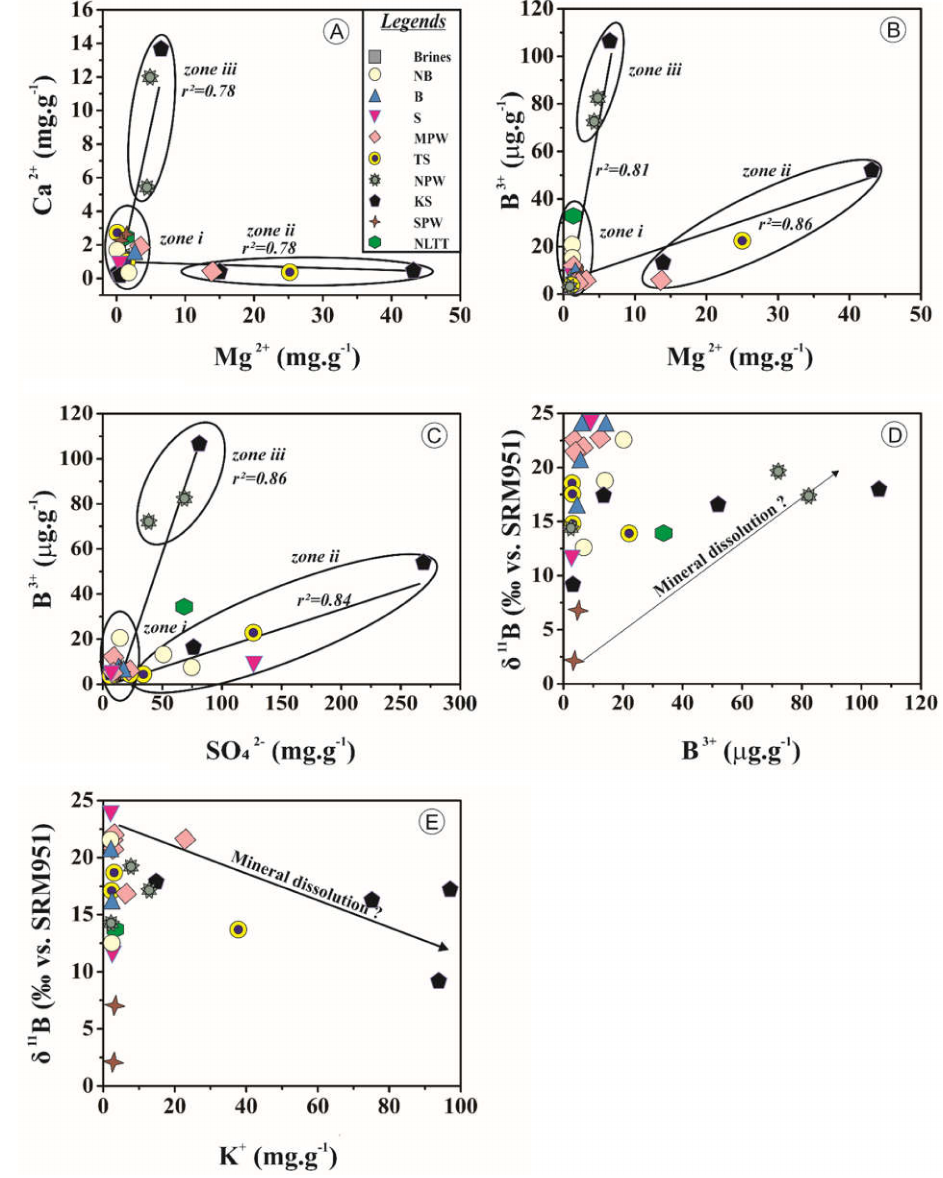
Figure 4. Ion–ion and ion- δ 11B covariations in the halite samples. ( A ) Ca 2+ vs. Mg 2+ . ( B ) B 3+ vs. Mg 2+ . ( C ) B 3+ vs. SO 4 2 − . ( D ) δ 11 B vs. B 3+ . ( E ) δ 11 B vs. K +